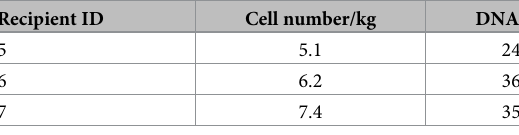
Blood chemistry. Blood chemistry analysis was conducted by a third-party reference lab- oratory. Only the abnormal values are included in Table 6. The full blood chemistry results are presented in S14 Table in S1 File. The tables include the values prior to the first transplant, 1 week following the first transplant and at the termination of the study. It is important to recog- nize that the duration was different for each group (Table 3). For several factors, the trans- plants normalized blood chemistry values, if not bringing them into the normal range. For example, dogs #1–4 had abnormally high creatinine kinase prior to the implantation proce- dure, but by the study end, the values had all normalized. Similar trends of normalization of values that were out-of-range prior to the transplants were identified for creatine kinase, glob- ulin, total protein, calcium, and potassium. The liver enzymes ALP, AST and ALT were high in all of the diabetic dogs (#5–7) but normalized after the transplants. However, dog #1 responded in the opposite manner with normal or low values prior to the transplant and ele- vated values after. Although he had no overt clinical signs of liver dysfunction through the study. Dog #1 had received the lowest dose of islets, thus, it seems unlikely that the reaction was due solely to the transplant. Hematology and urinalysis. Hematology analysis was normal for all readings with the exception of those shown in Table 7 (complete hematology values included in S15 Table in S1 File). Slightly low Mean corpuscular hemoglobin (MCH) was noted in the diabetic dog #7 prior to the transplant, which normalized by the termination of the study. When the values were calculated as concentrations all the dogs showed low levels of mean corpuscular hemo- globin concentration (MCHC), but again normalized by the end of the study. The same was true for the eosinophil count for dog #4. Only dog #5 had a normal value that became abnor- mal after the transplant. His monocytes count was slightly elevated 1 week after the transplant, but again normalized by the end of the study. All other hematological values were within the normal range. Urinalysis revealed some blood in the urine in 2 dogs before the transplants, which did not change after transplantation. Analysis of coagulation factors revealed the fibrin- ogen levels rose in 5 dogs after the transplants, but by study ends, only 2 dogs had values above the normal range.